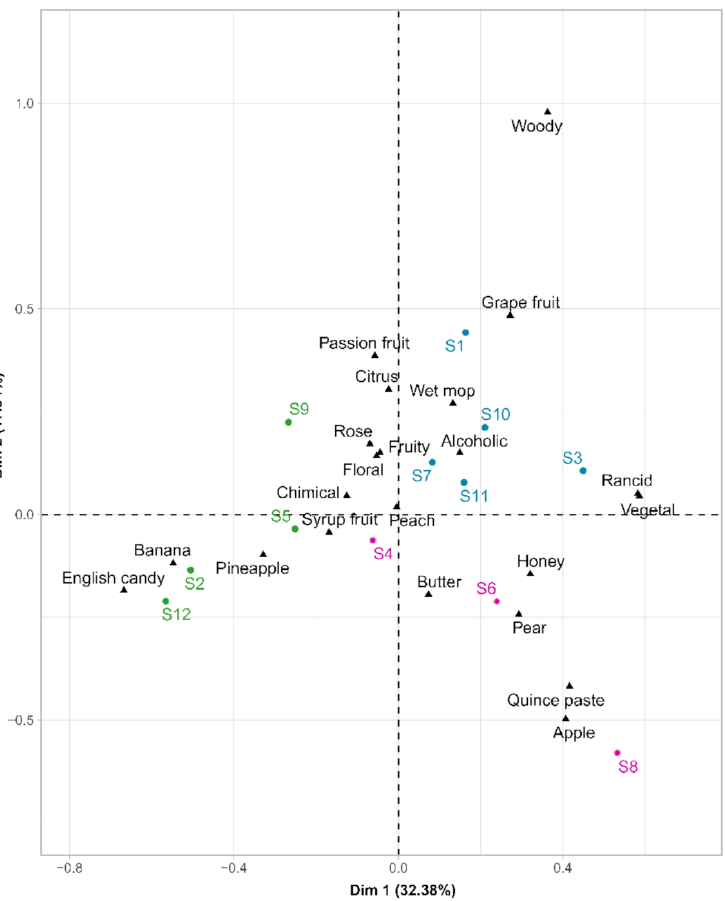
Figure 5. Biplot of the correspondence analysis of the general description of the twelve wines. Colors indicate the clusters obtained by HCA (using Ward’s criterion) on the two first CA